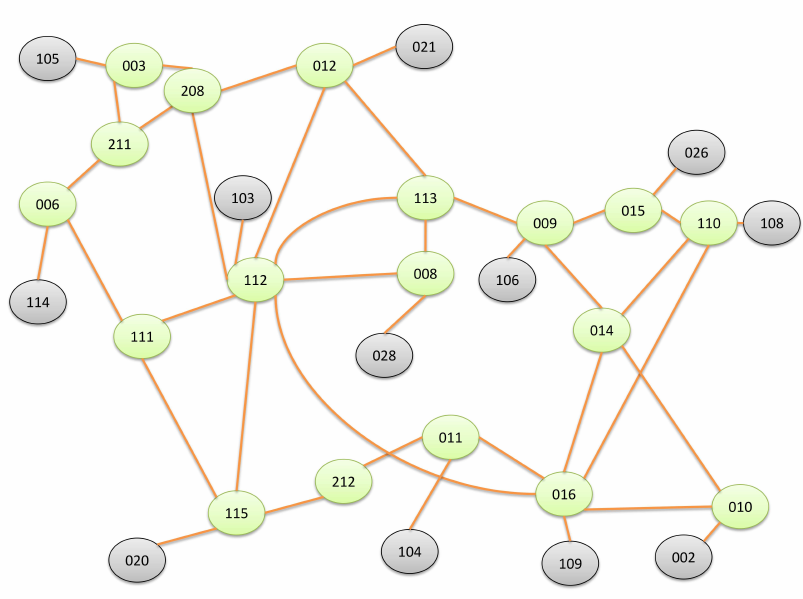
Figure 2. Experimental topology. Grey nodes are sources/destinations and are always ON. Intermediate nodes can be put to sleep and their power consumptions are